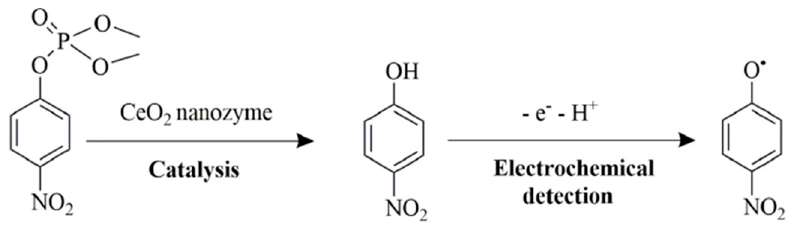
Figure 16. Schematic of nanoceria as a bifunctional material for catalysis and electrochemical de- tection of methyl-paraoxon. (Reprinted with permission from [143] . Copyright © The